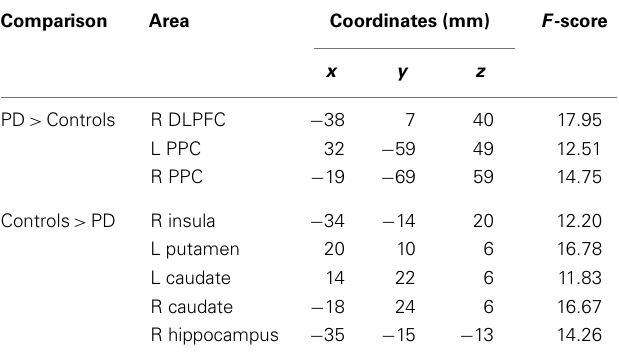
Table 2 |VS > VP second-level analysis results